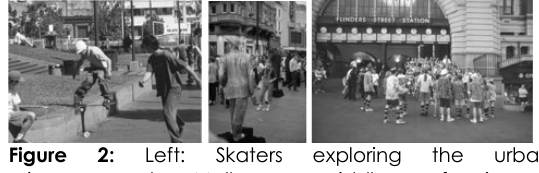
Figure 2: Left: Skaters exploring the urban microgeography, Melbourne; middle: performing as ‘statues’, Leicester Square, London; right: Play interrupts instrumental flows, entry to Flinders Street Railway Station, Melbourne (Stevens, 2006).